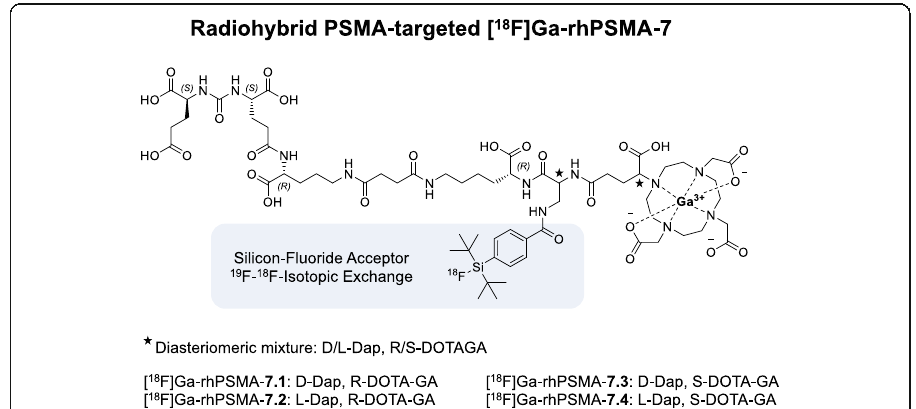
Fig. 1 Structural formula of the radiohybrid PSMA-targeted ligand [ 18 F]Ga-rhPSMA-7 equipped with a Silicon-Fluoride Acceptor for 18 F-labeling in an isotopic exchange reaction. [ 18 F]Ga-rhPSMA-7 represents a mixture of four stereoisomers (7.1, 7.2, 7.3, 7.4), differing in the stereoconfiguration of the diaminopropionic acid branching unit (D-Dap or L-Dap) and the glutamic acid pendant arm at the DOTA-GA-chelator (R- DOTA-GA or S-DOTA-GA; DOTA-GA: 2-(4,7,10-tris(carboxymethyl)-1,4,7,10-tetraazacyclododecan-1-yl)pentanedioic